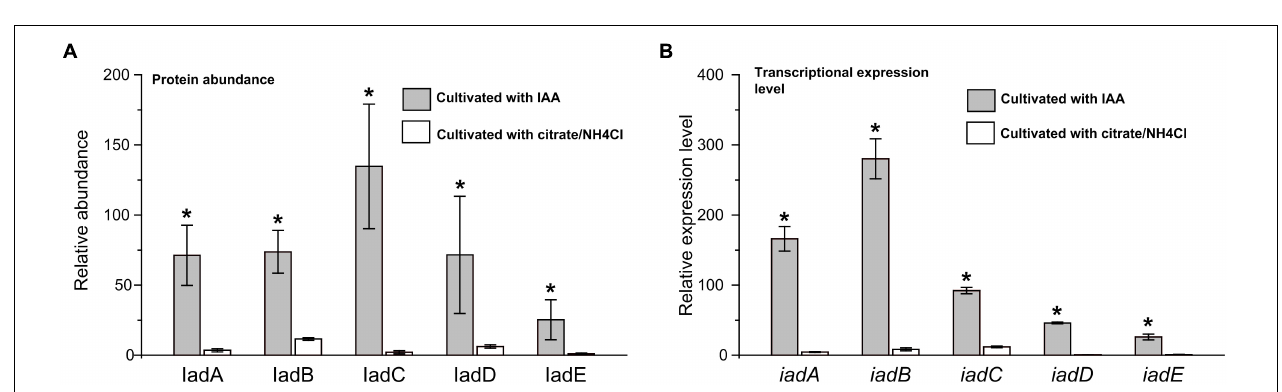
FIGURE 6 | Graphical representation of iad gene cluster in strain Pseudomonas sp. LY1. Arrows indicate the size and direction of transcription of each gene. The numbers above the arrows indicate the amino acid sequence identity between the marked protein and the corresponding orthologous protein from Pseudomonas sp. LY1. Highlighted in cyan are the iad ( iac ) genes, in blue are the regulator genes, in orange are the catBCA genes, in purple are the paaIJD genes, in gray are the genes with unknown function, and in yellow and green are the pcaABCDEF genes.